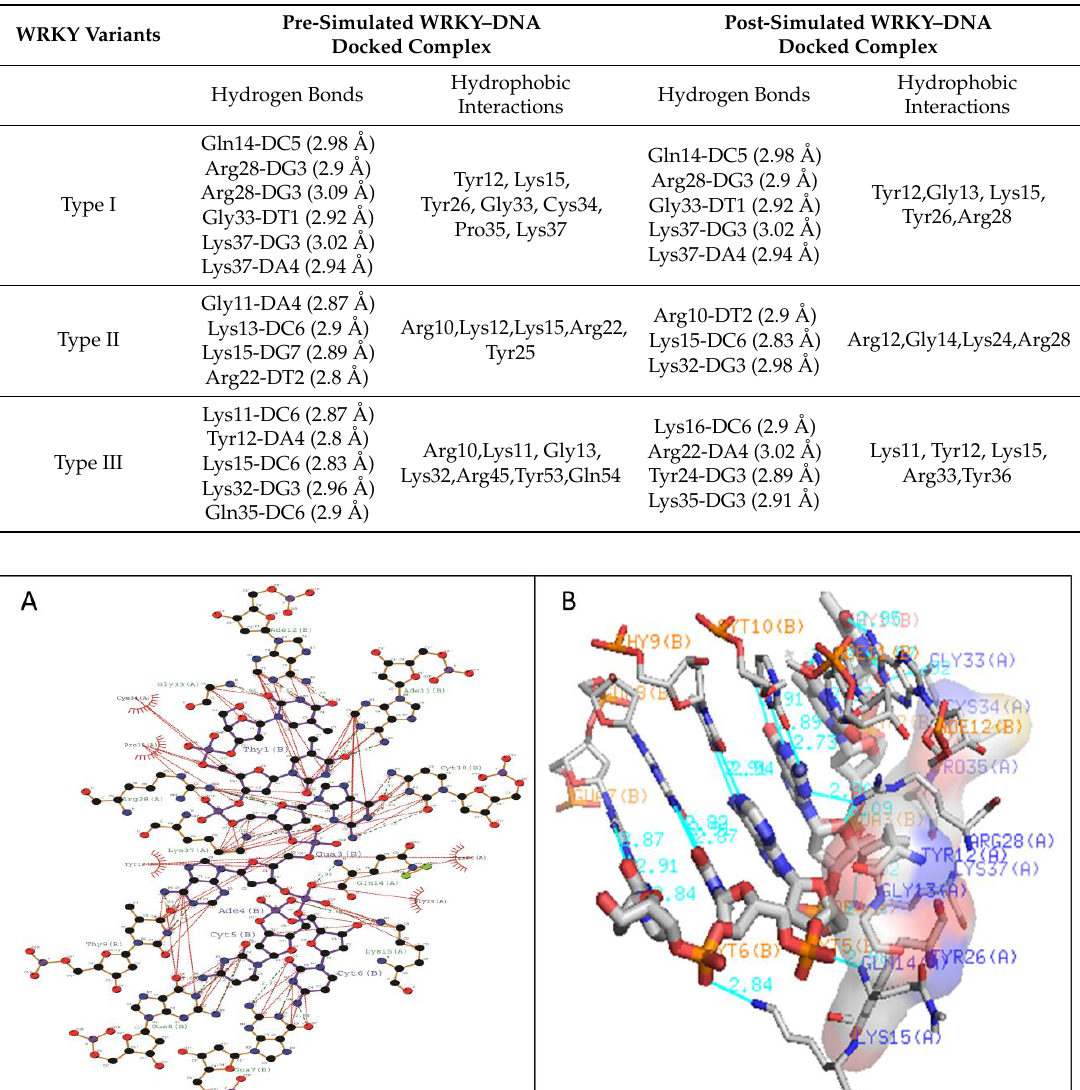
Table 1. Residues that participated in hydrogen bond and hydrophobic interactions in the WRKY – DNA complexes.